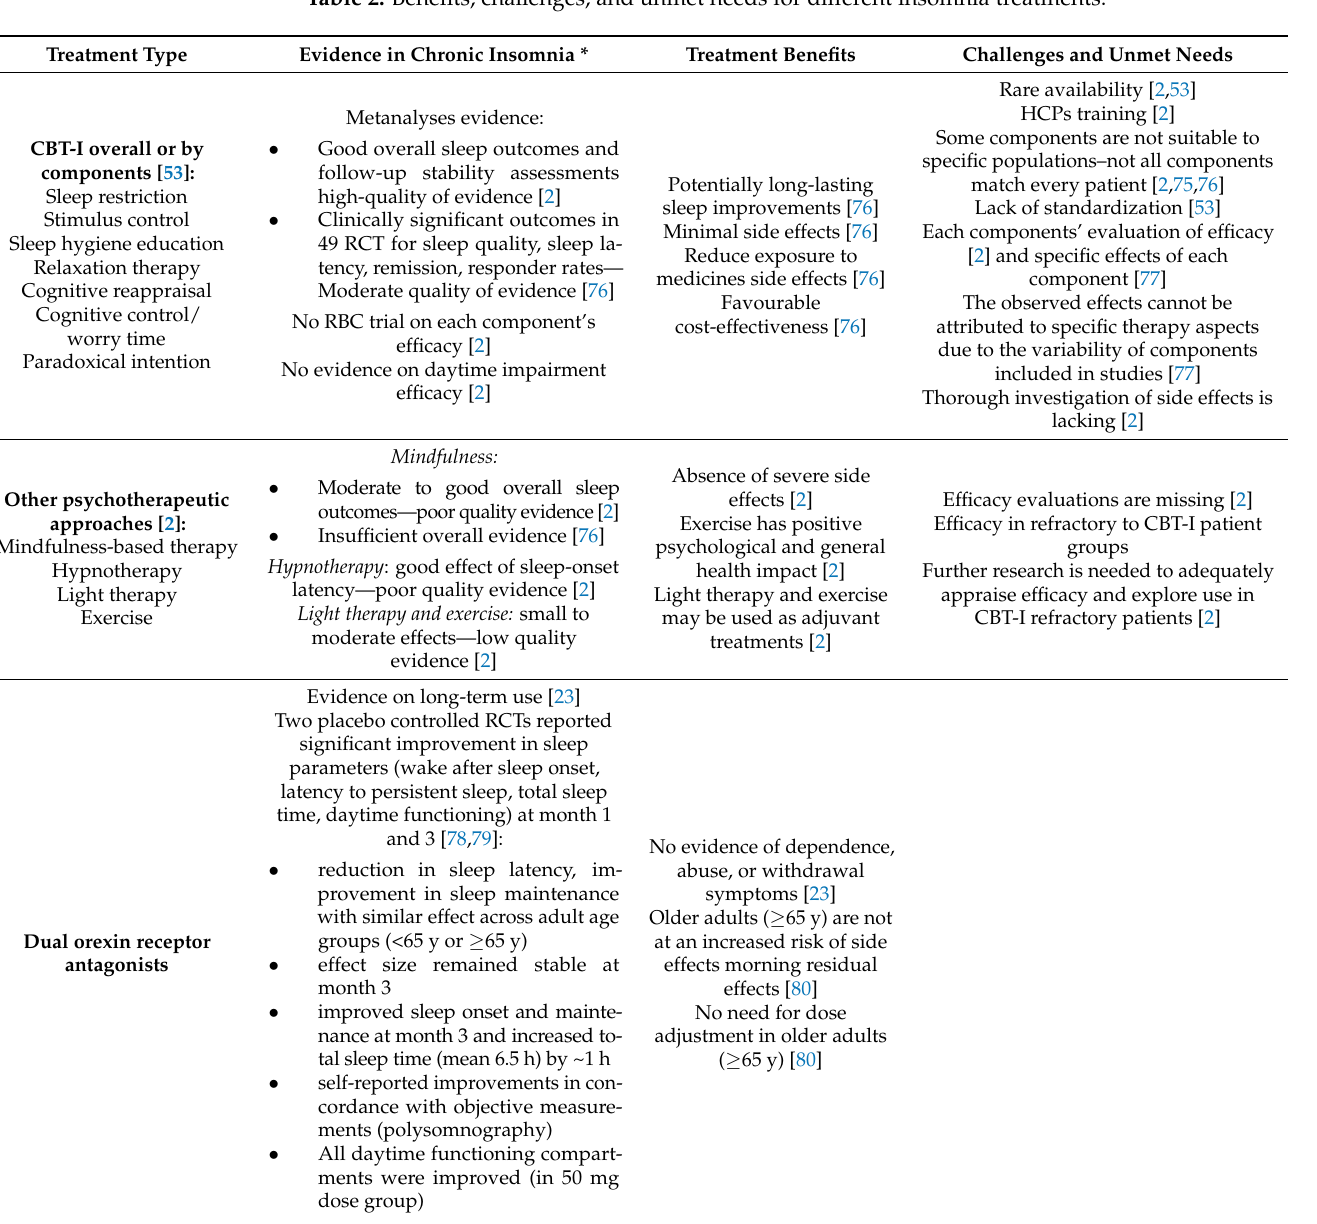
Table 2. Benefits, challenges, and unmet needs for different insomnia